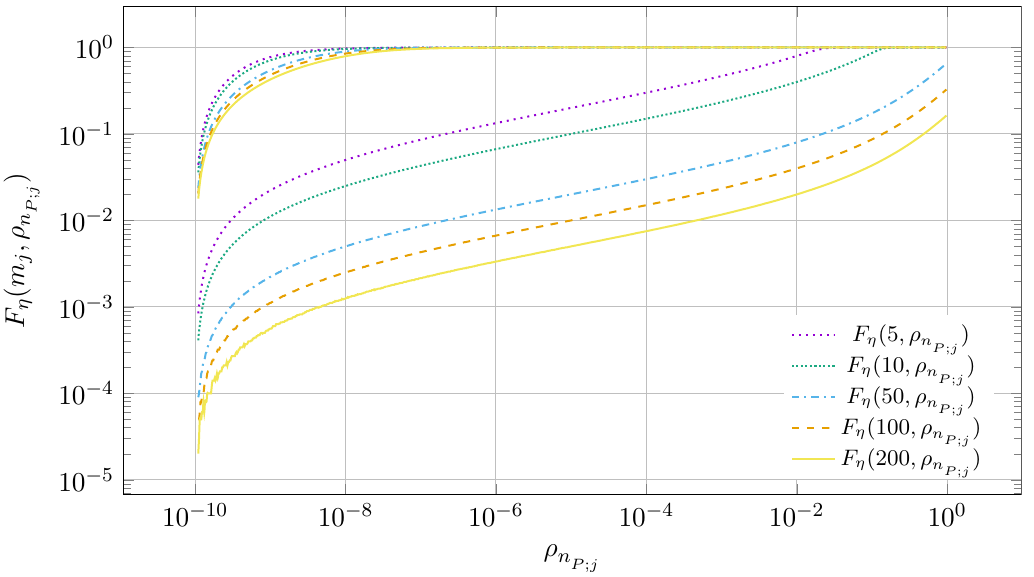
( m ) for relative change in bond , ρ j n max / min P ; j